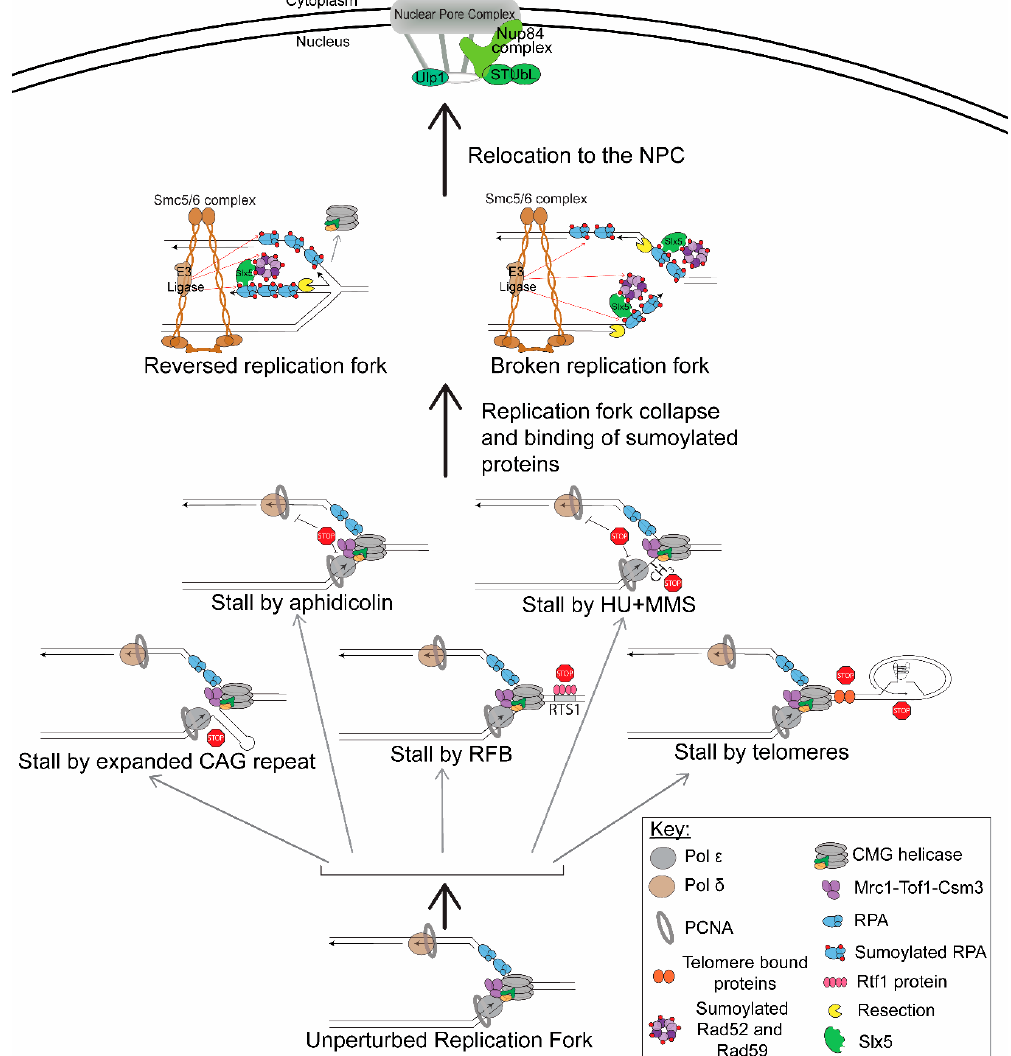
Figure 1. Types of replication stress that cause fork collapse and lead to relocation to the nuclear pore complex (NPC). Upon replication stress, which can be caused by many different mechanisms, normal unperturbed replication forks can stall. Several mechanisms are shown in this model: structure-forming sequences (expanded CAG repeats), protein-mediated replication fork barriers (RFBs), telomere sequences, aphidicolin, and HU + MMS. After a replication fork stalls, it can turn into a fork collapse. This is marked by dissociation of the replisome and could possibly include breaks at the replication fork; the position of the various replisome components during fork collapse at these different barriers is not known and shown for diagrammatic purposes only. For simplicity, two structures that could result from a fork collapse are shown: a reversed replication fork and a broken replication fork, although we note there are other possible structures. For example, a reversed replication fork could be cleaved by endonucleases and, in turn, result in a broken replication fork with a different structure than the one shown here. Nonetheless, both reversed and broken replication forks can be substrates for resection, which is important to generate ssDNA that binds RPA. Repair proteins, sumoylated by E3 ligases (SUMO is indicated by the red circles), bind to the ssDNA and interact with the SIM domains in Slx5 (or its homologs). This stimulates relocation to the NPC through the interaction of Slx5 with the NPC protein Nup84 (or its